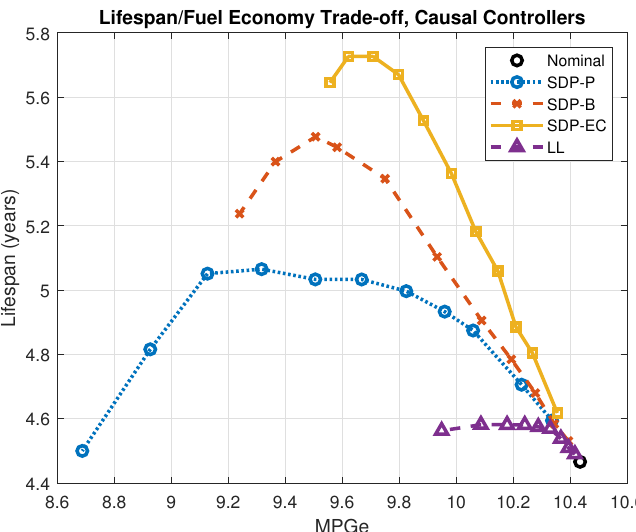
Figure 9. Comparison of energy consumption and battery aging for the four causal control methods, N pc =